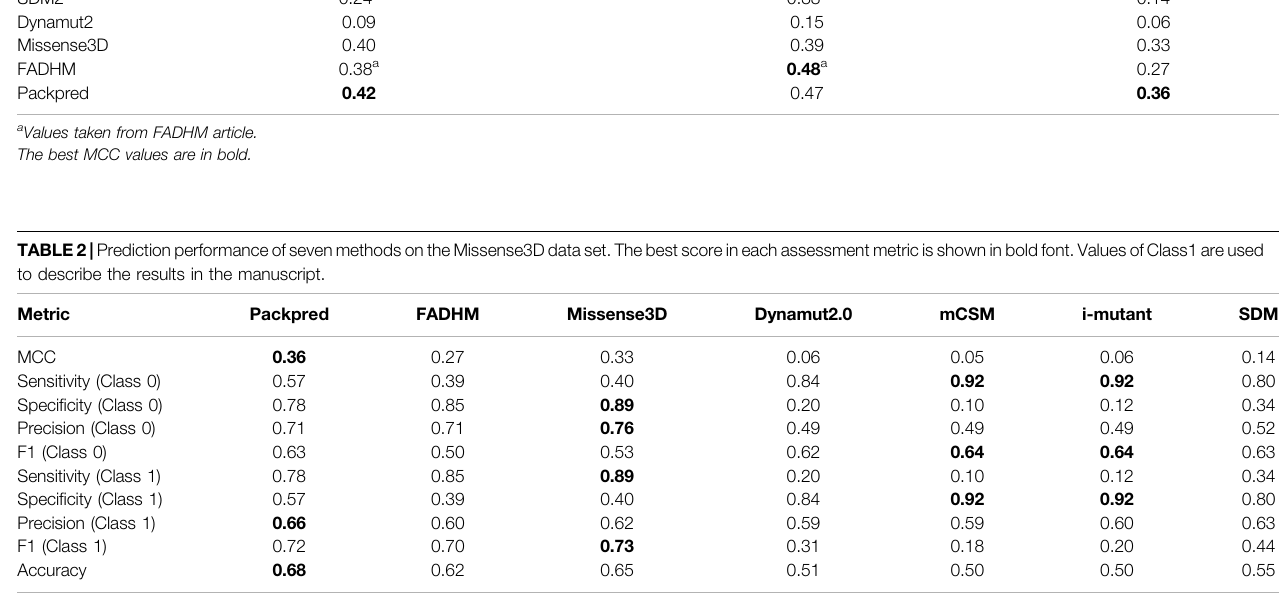
TABLE 1 | Performance of some methods on T4, CcdB saturation mutagenesis, and Missense3D data sets. Method MCC for T4-lysozyme saturation mutagenesis data set MCC for CcdB saturation mutagenesis data set MCC for Missense3D data set i-mutant 2.0